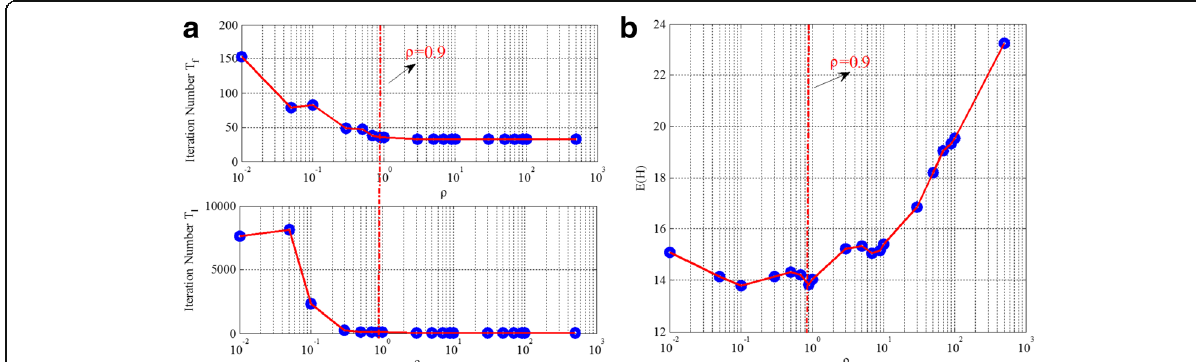
Fig. 6 The diagram of the effect of factor ρ to the algorithm, where a shows the trends of iteration number of first path and TGSARWI paths with the changes of ρ , and b shows the trend of the minimum exposure obtained by TGSARWI DA with the changes of